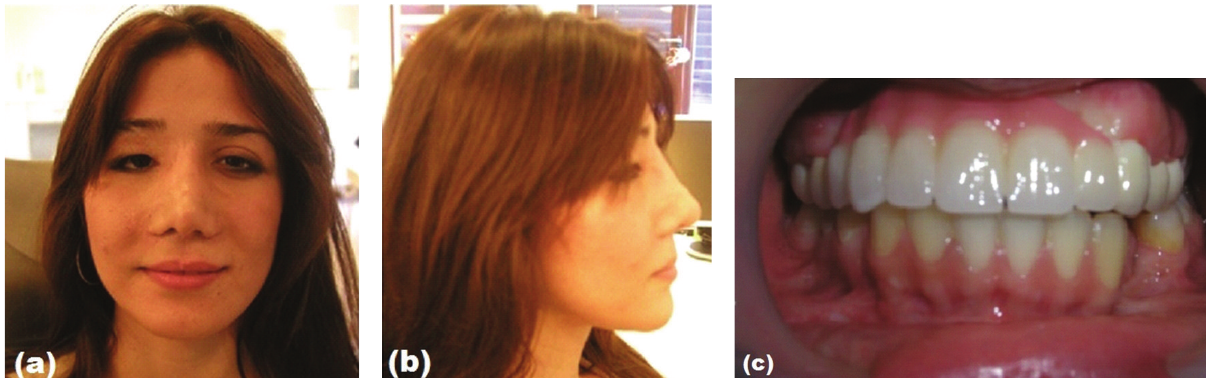
Figure 6: (a, b) Facial view of patient after final treatment with prosthesis, (c) intraoral view of final zirconia-based prosthesis.